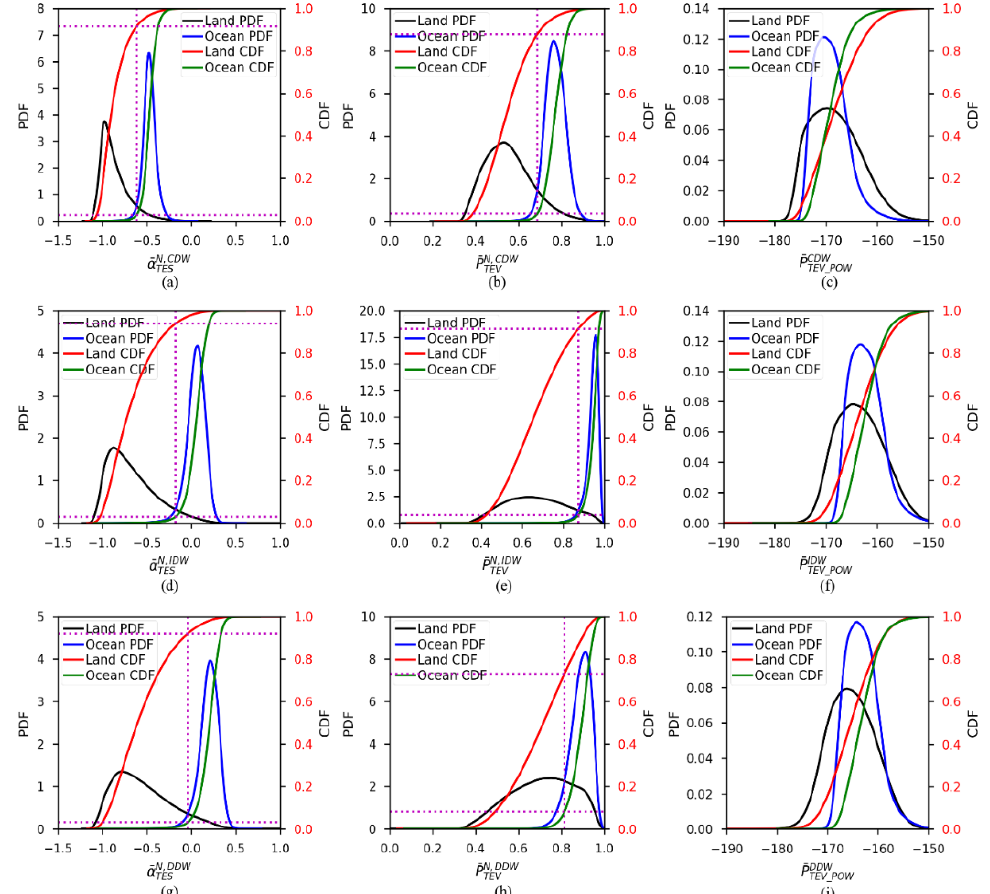
Figure 4. Statistic performance of trailing edge slope (TES), the average volume of the normalized time-delay waveform (DW) trailing edge (TEV), average absolute scattering power of the DW trailing edge (TEV_POW) derived from central Doppler time-delay waveform (CDW; a – c ), integrated time-delay waveform (IDW; d – f ), and deviation of time-delay waveform (DDW, g – i ) over land and ocean surface, dataset collected from the cyclone global navigation satellite system (CYGNSS) level-1B in January 2018.